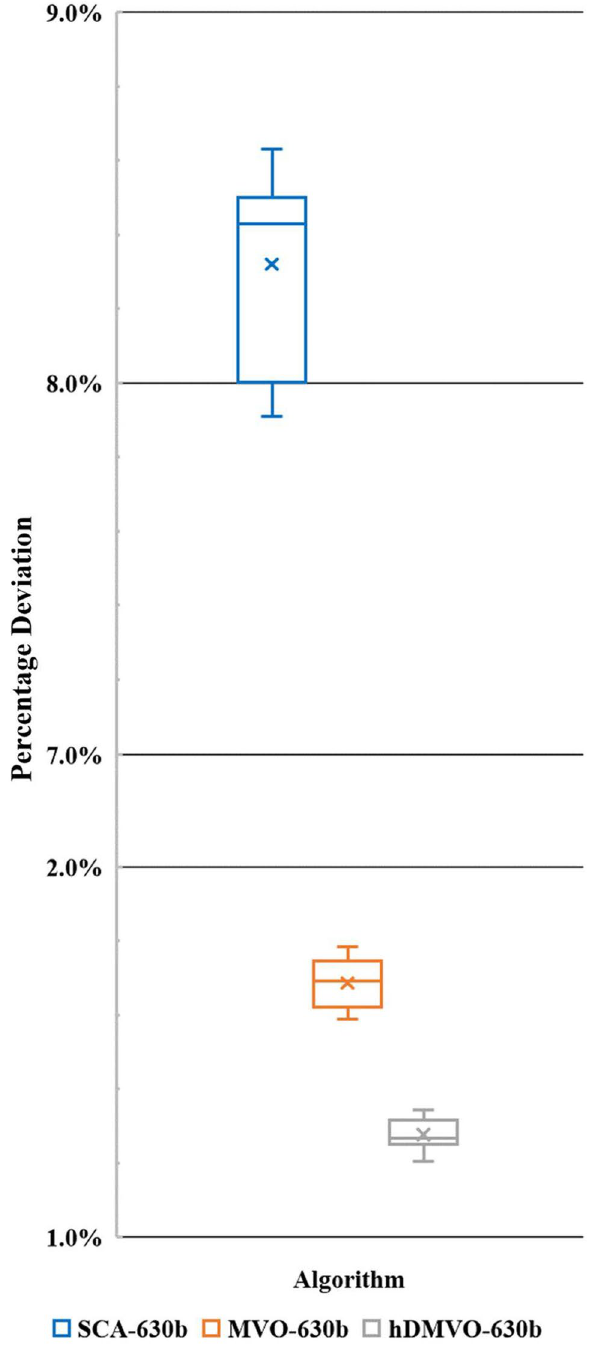
Figure 14. Percentage deviations of hDMVO, MVO and SCA in problem